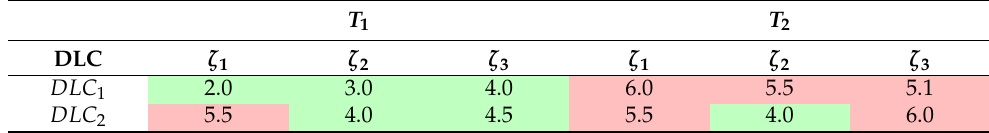
Table 4. Format of TMD motion